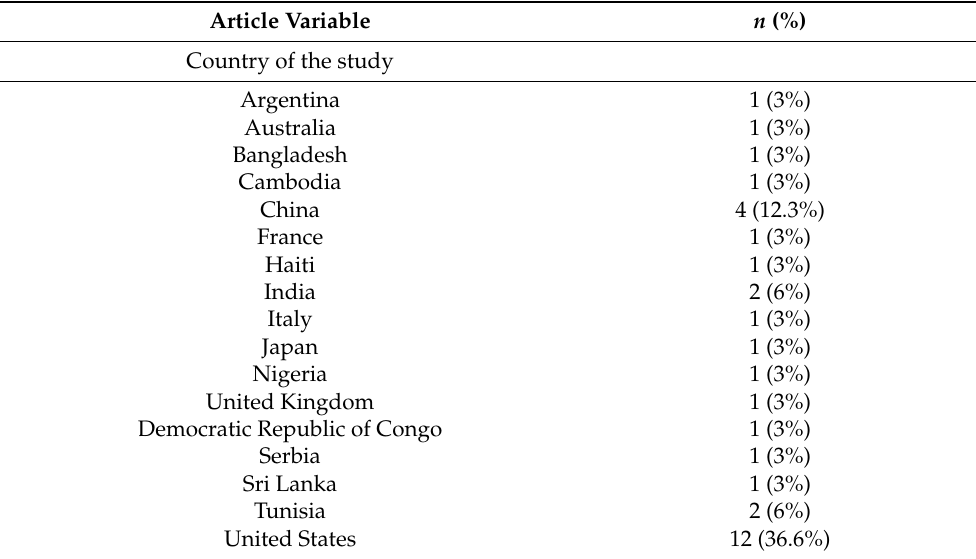
Table 7. Information on the spatiotemporal scenario and associated factors, collected from 33 articles on dog bites resulting in